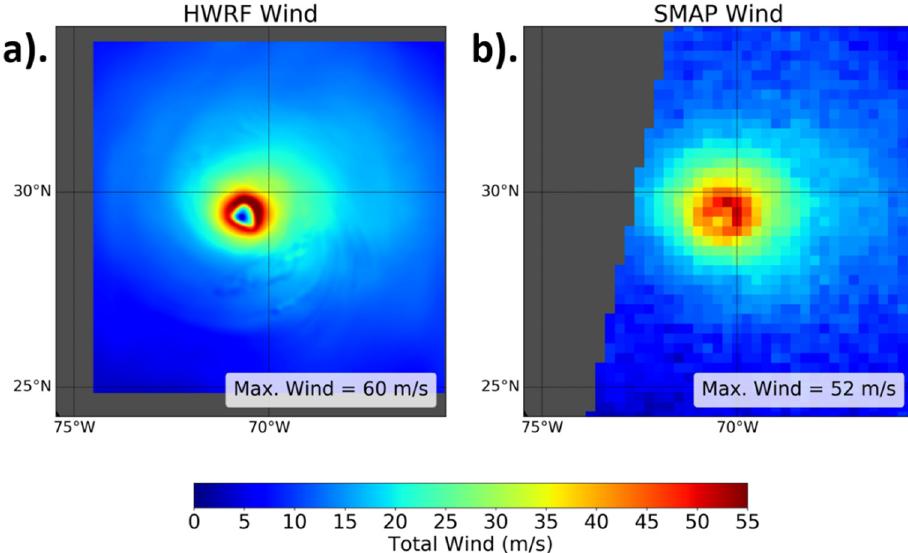
Figure 2. Wind fields of Hurricane Florence on 12 September 2018 from the HWRF model at its original resolution of ~1.5 km at 12:00 UTC ( a ) and from SMAP TC-winds at their native resolution of 40 km at 10:50 UTC ( b ). The maximum wind value for each field at these resolutions is shown in the bottom right of each panel.